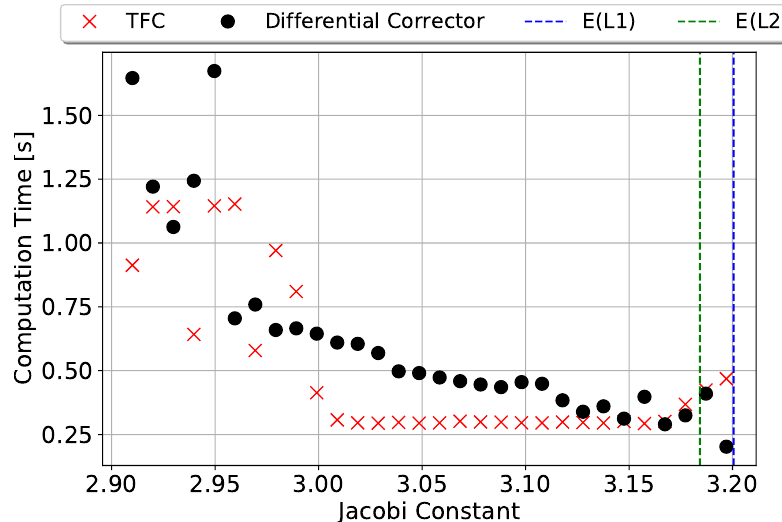
Figure 5. Computational time of the the TFC method for the trajectories plotted in Figure 2a compared to that of the differential corrector. The TFC method holds a slight speed gain over the differential corrector.